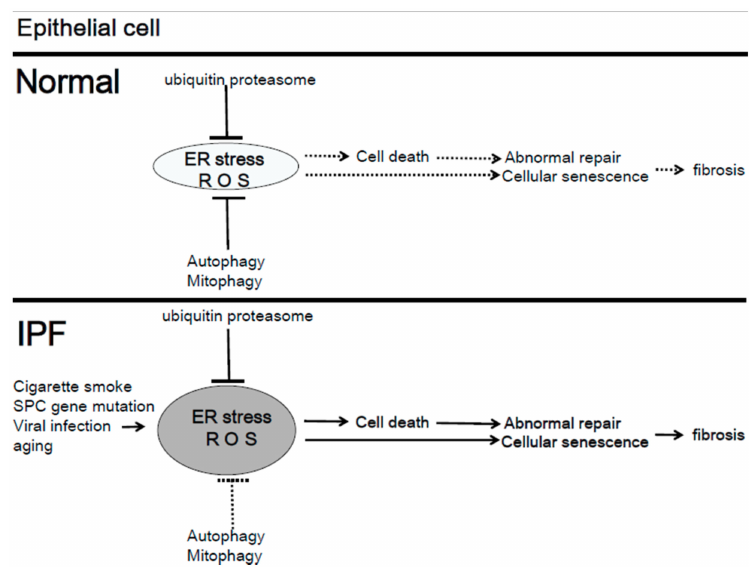
Figure 3. The role of endoplasmic reticulum (ER) stress, autophagy, and mitophagy in the pathogenesis of Idiopathic pulmonary fibrosis (IPF). In epithelial cells, excessive ER stress induces cell death and senescence. Dysregulated autophagy and mitophagy accelerate ER stress-induced cell death and